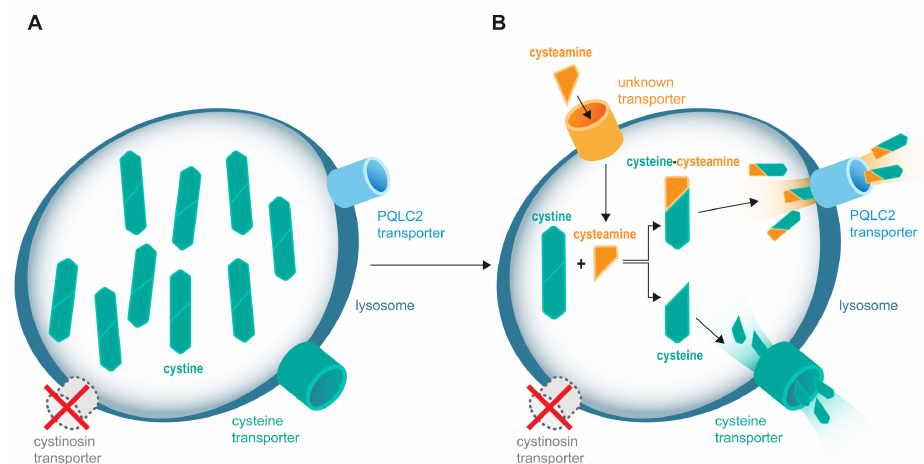
Figure 1. Cysteamine depletes lysosomal cystine accumulation in cystinosis. ( A ) The absence or the lack of function of the cystinosin transporter causes intracellular accumulation of cystine. ( B ) The administration of cysteamine allows the depletion of excess cystine from lysosomes in